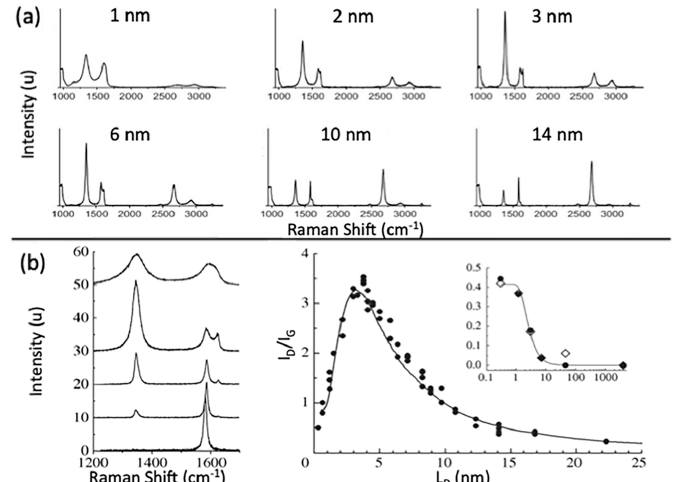
Figure 24. ( a ) illustration of Raman spectra of graphene oxide (GO) as a function of the distance between defects (reprinted with permission from [192]); ( b ) the ratio of I D /I G from different monolayer graphene samples as a function of the average distance L D between defects that are induced by the Ar + ion bombardment, the inset ratio of I D /I G versus L D for two graphite samples (reprinted with permission from [193]).